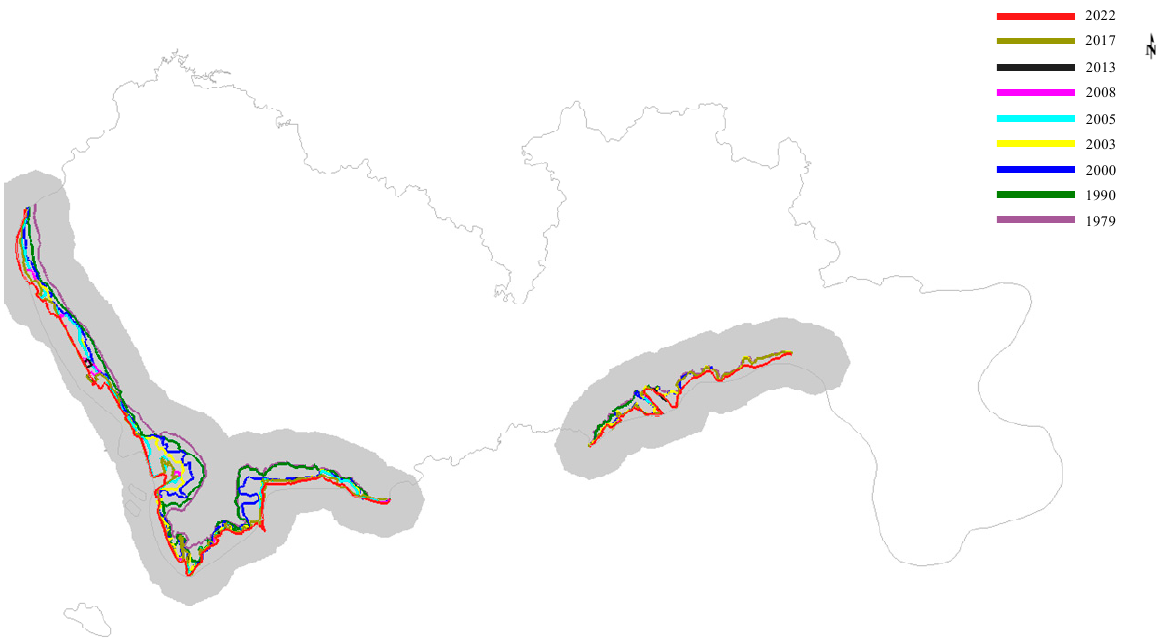
Figure 6. The coastline changes in Shenzhen from 1979 to 2022. The shadow area denotes the 3 km buffer zone of the coastline.